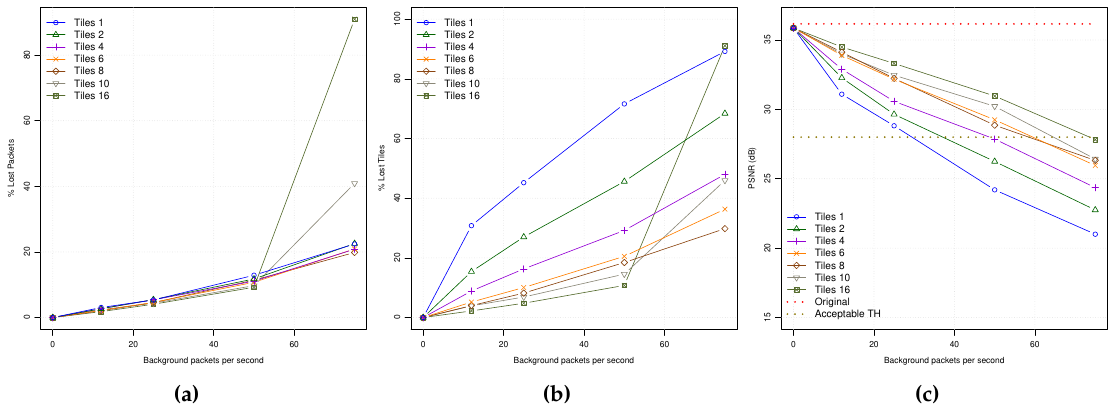
Figure 6. QoE statistics for AI for all the tiles per frame layouts: ( a ) PLR. ( b ) TLR. ( c )